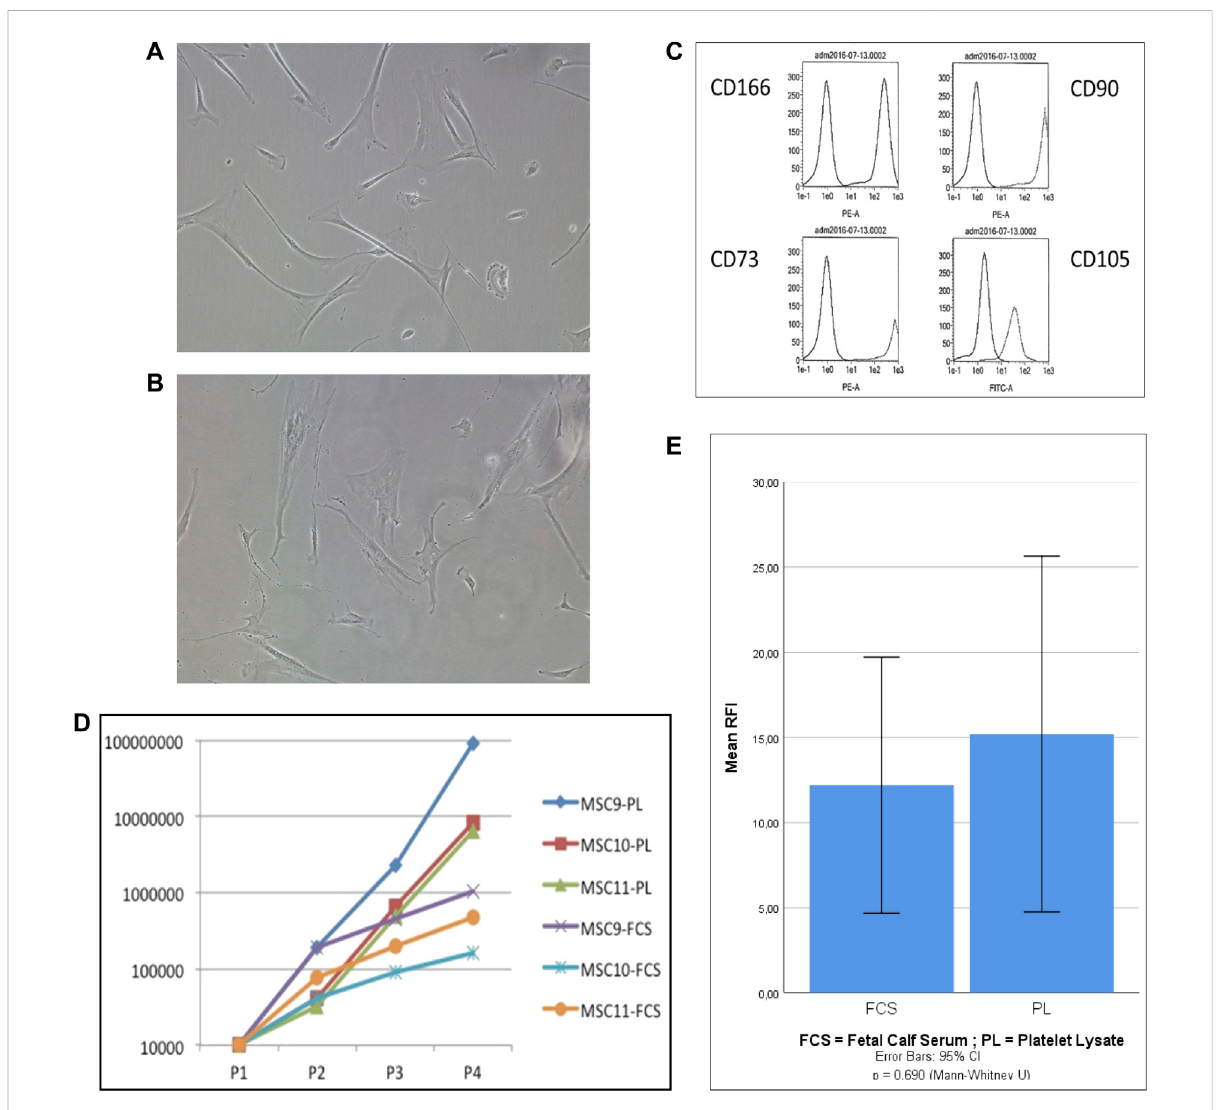
FIGURE 1 Characterisation of in vitro expanded MSCs. (A,B) Representative photographs of MSC ’ s cultured in PL-based (A) and FCS-based (B) expansion medium (30×); (C) : Phenotype MSCs expanded in PL-based medium: the fi rst peak represents the negative control antibody whereas the second peakrepresentstheantigen-speci fi cantibody; (D) :ProliferationcapacityofMSCs expandedinPL-basedmedium versusFCS-based medium( n =3), the number of cells is presented according to the number of passages; (E) : In vitro migration of MSCs cultured in FCS-based medium and PL- based medium ( n = 5). Migration is expressed as mean relative fl uorescence intensity (RFI). (p= 0.69, 95% CI, Mann Whitney)